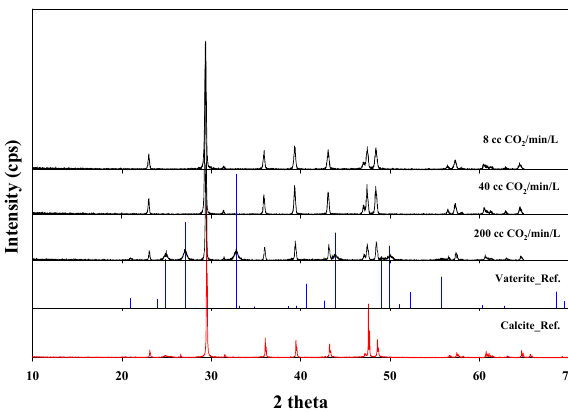
Figure 8. The XRD spectra of particles precipitated during the carbon mineralization processes at 8, 40 and 200 cc CO 2 /min/L.